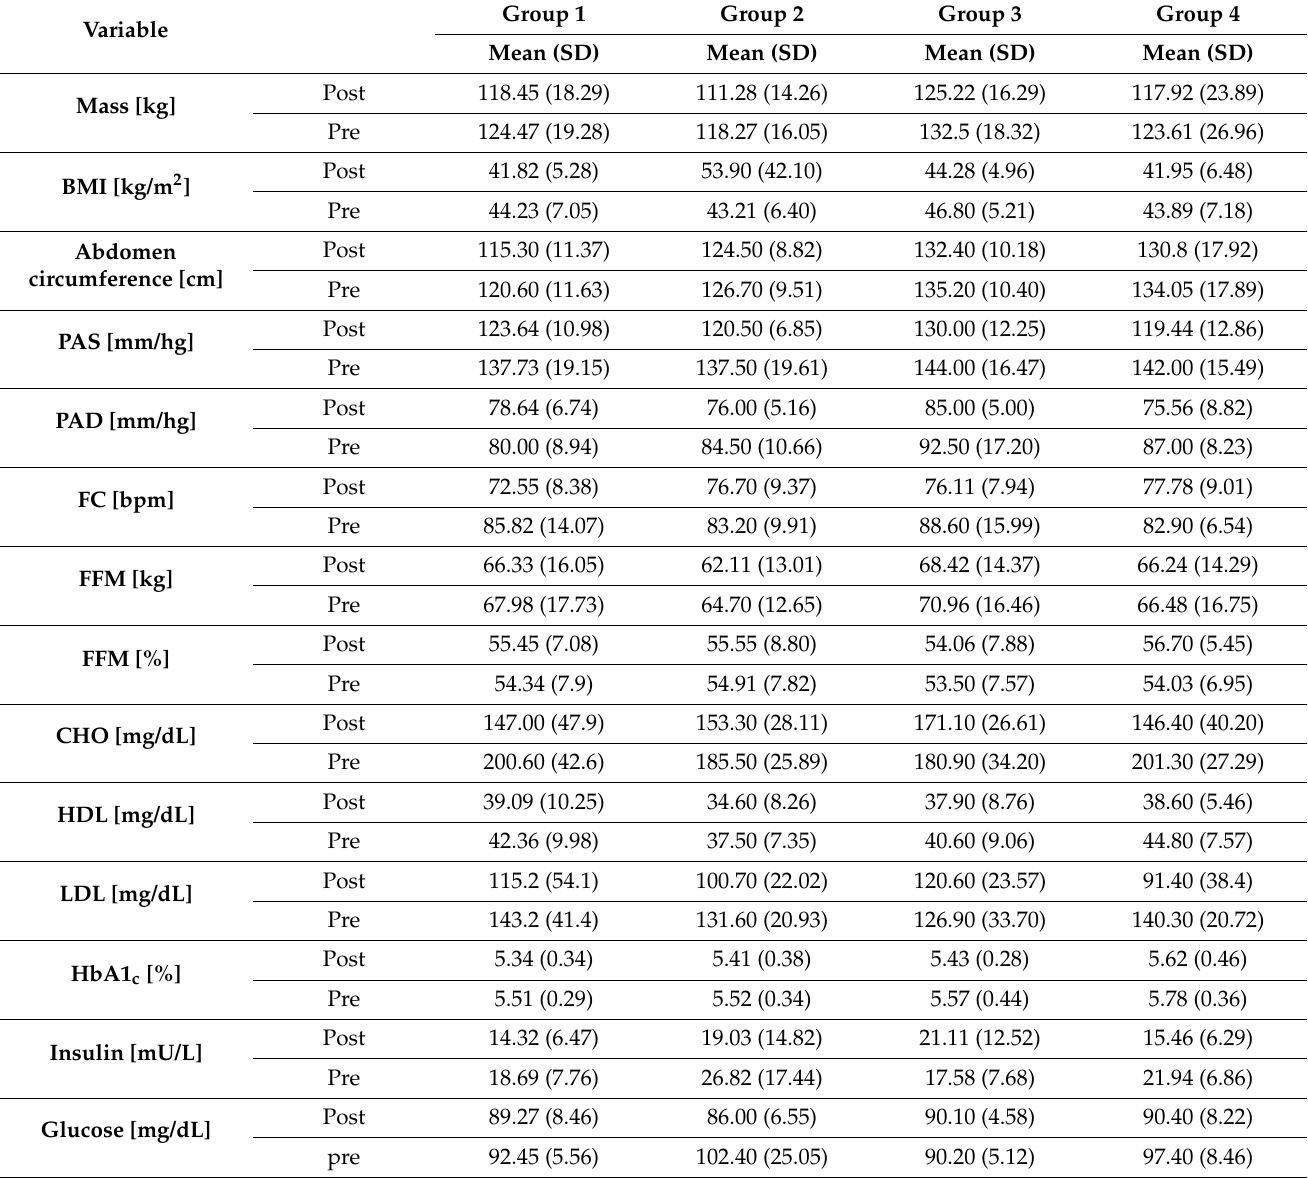
Table 2. Mean and standard deviation of metabolic and body composition characteristics of the four groups. PAS, systolic blood pressure; PAD, diastolic blood pressure; FC, heart rate; FFM, fat free mass in Kg; FFM%, fat-free mass in %; CHO, total cholesterol; HDL, cholesterol; LDL, cholesterol; HB1Ac, glycated hemoglobin; insulin;